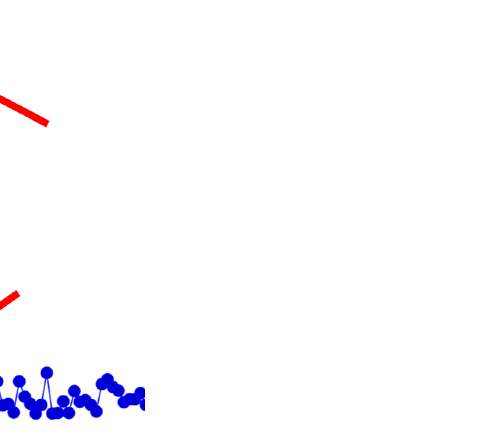
Figure 31. Image indicating the sharp rise and fall in the error with a multiagent